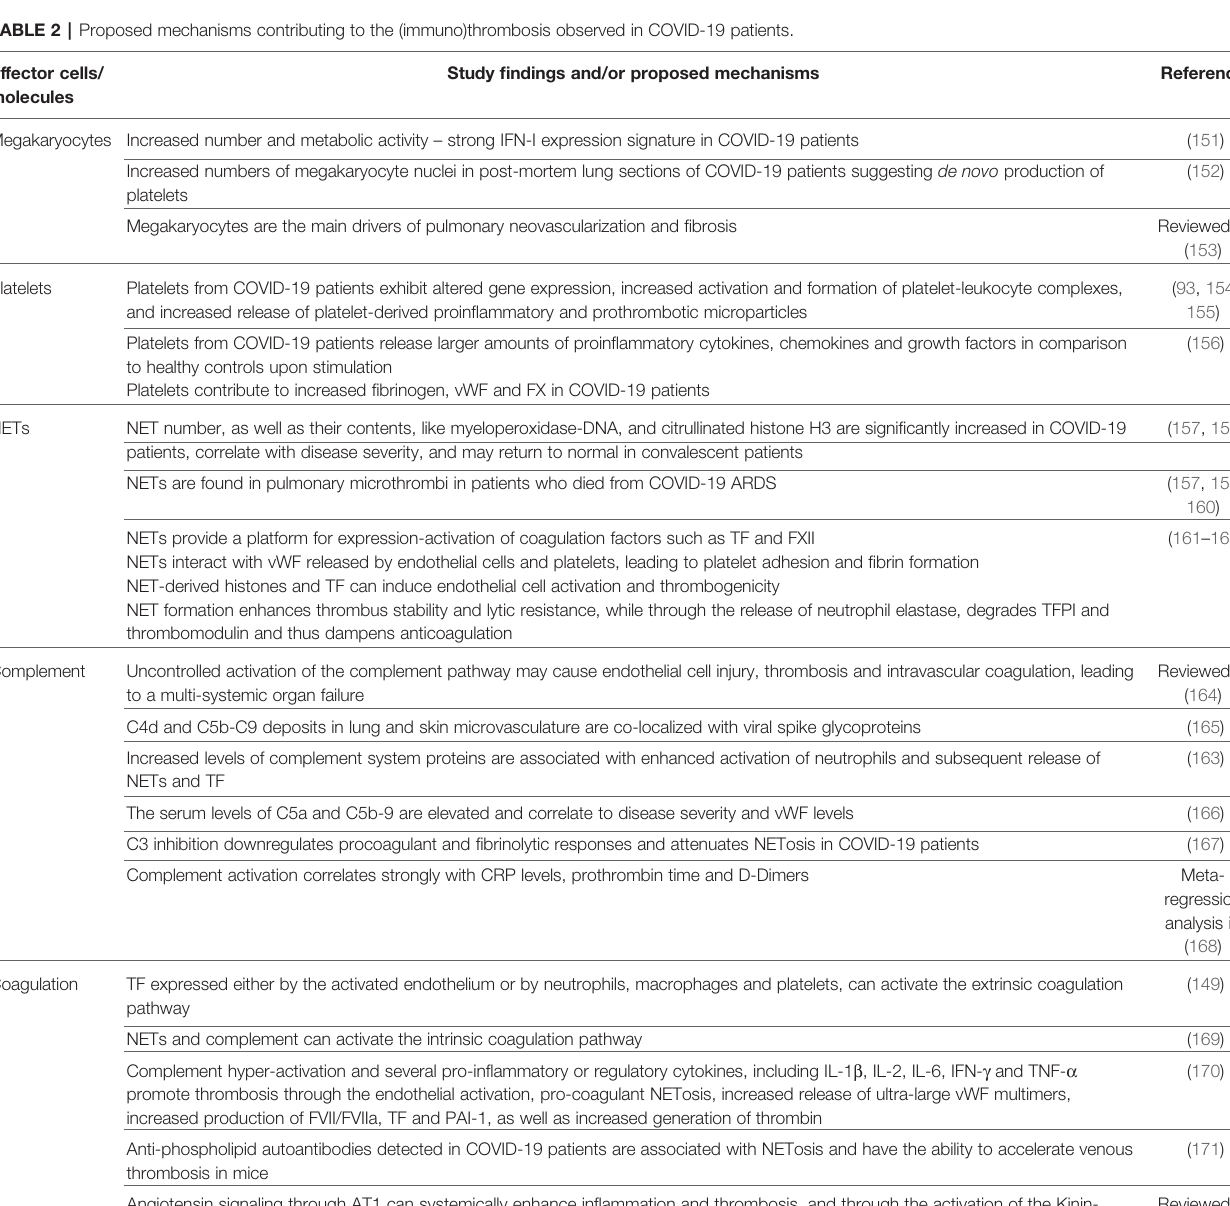
Study fi ndings and/or proposed